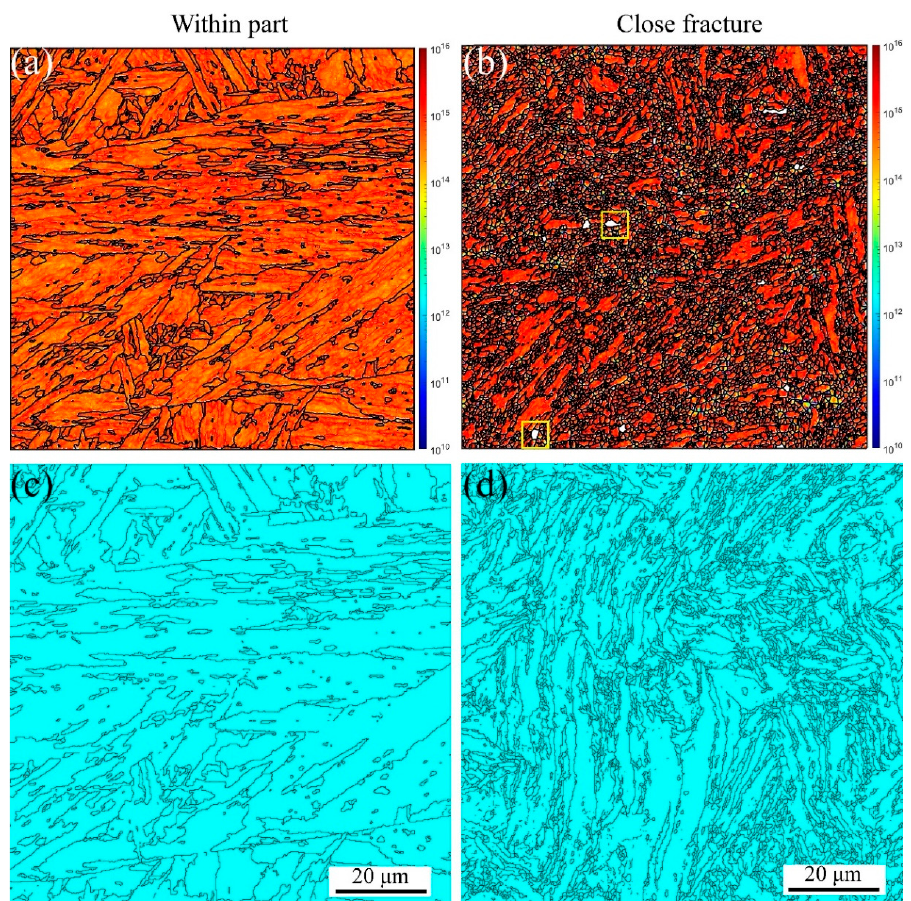
Figure 4. EBSD maps under different strain gradients at the strain rate of 5 × 10 − 3 s − 1 under RT ( Red arrows indicate voids within the grain and along the line, green arrows indicate shrinking micro- structures, and yellow arrows point to voids and shrinking cracks). ( a , b ) IQs; ( c , d ) IPFs; ( e , f ) miso- rientation angles; and ( g , h ) inverse polo figures.